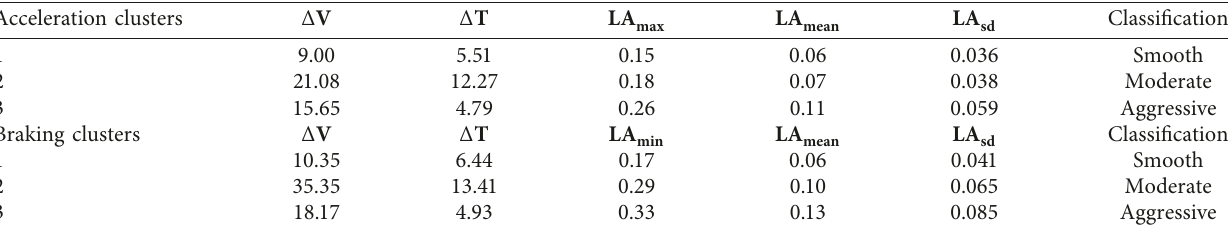
Table 6: Level-1 Cluster centers of acceleration and braking maneuvers.